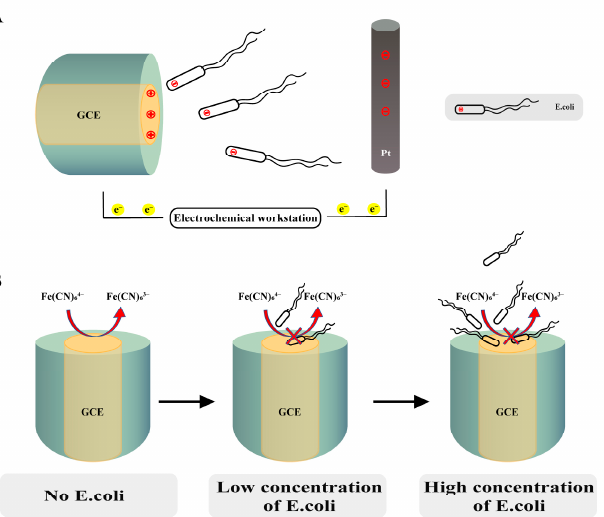
Figure 1. Schematic diagram of the proposed detection method. ( A ) E. coli migrates towards GCE in the electrolyte; ( B ) adsorption of E. coli on the glassy carbon electrode (GCE) surface, resulting in electron transfer being blocked.